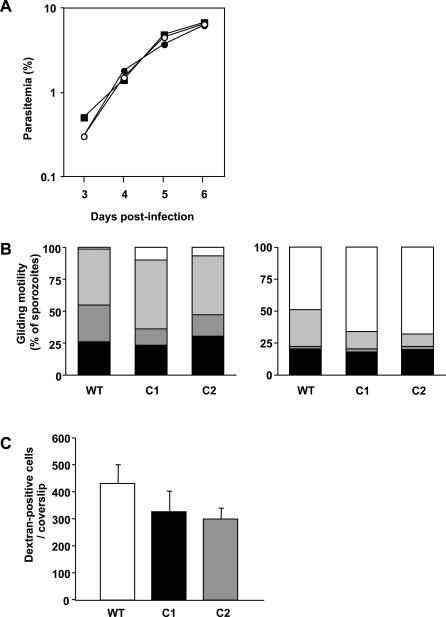

PbACα- has normal blood-stage growth rates and sporozoite motility.(A) Growth curves of P. berghei WT (black squares), PbACα- C1 (black circles) and C2 (white circles) in mice. (B) Gliding motility of sporozoites from WT, PbACα- C1 and C2 in the presence (right panel) or absence (left panel) of mouse albumin. Percentage of sporozoites that do not glide or do less than a complete circle (black bars), gliding sporozoites exhibiting 1 (dark gray bars), 2 to 10 (light gray bars), or >10 (white bars) circles per trail. (C) Migration through Hepa1-6 cells was measured as the number of dextran positive cells per coverslip. The difference between C1 or C2 and WT is not significantly different (p>0.05).